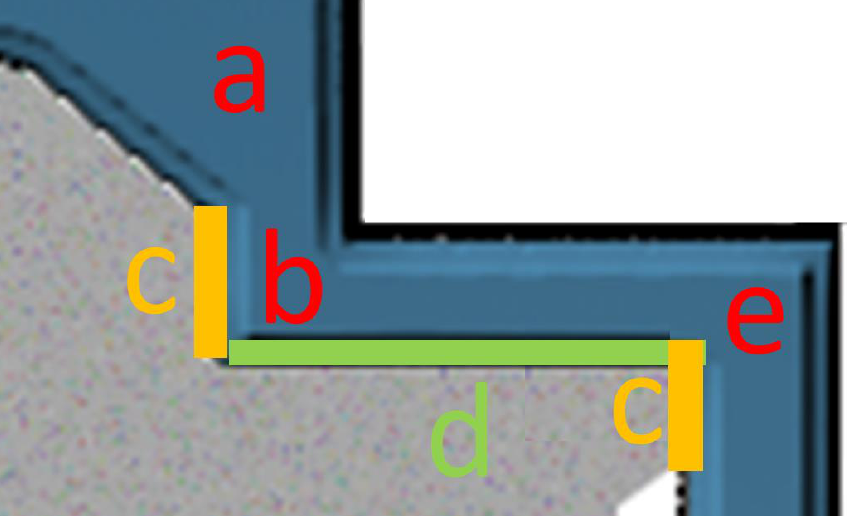
Figure 10. Detail of the MDZ on Figure 1b presenting the location where the individual stages of severe plastic deformation occur. The meaning of areas ( a – e ) is given in the text above the Figure. The first deformation process during CSET is the extrusion of the billet around the mandrel tip. The equivalent strain for extrusion processes can be expressed as [16,17]